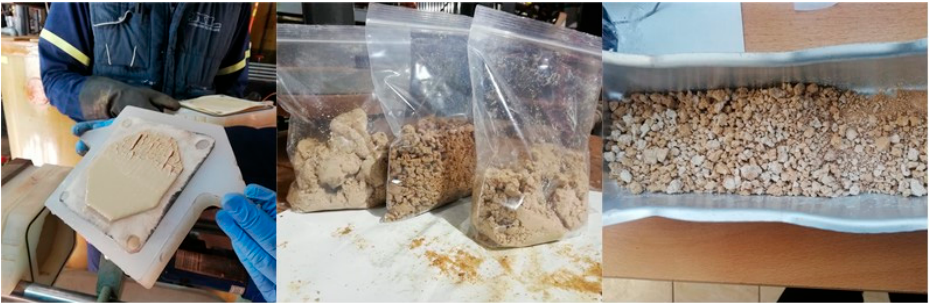
Figure 5. Sc crude conc. 22% produced at MYTILINEOS-II-VI pilot plant.